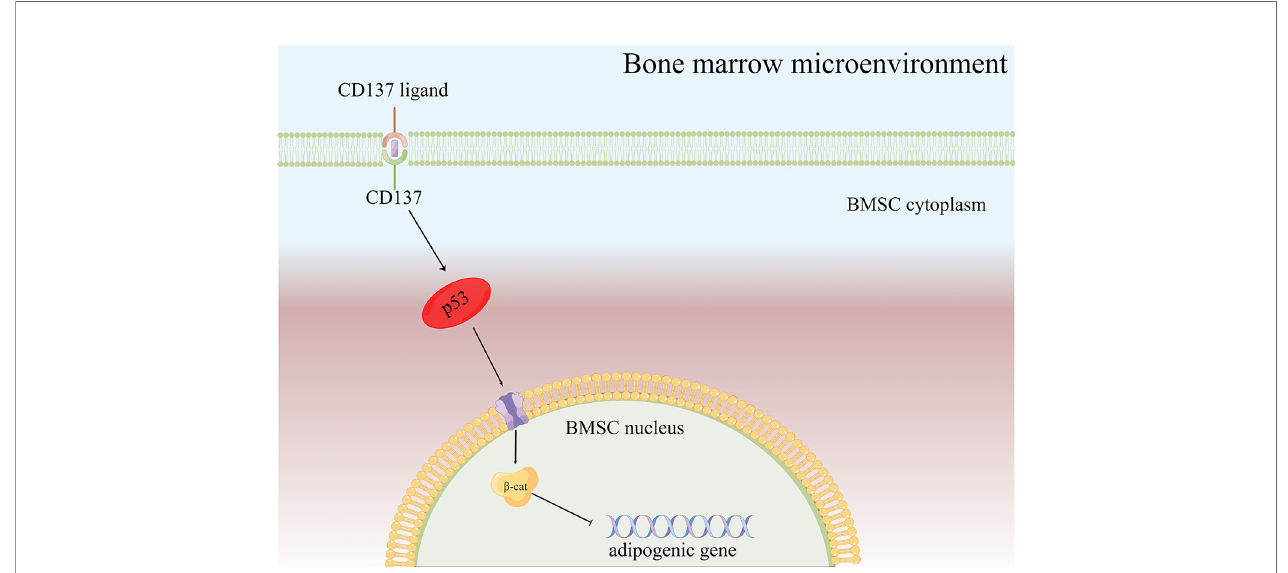
FIGURE 5 | Diagram of the possible mechanism of bone loss via the CD137-p53 Wnt/ b -catenin signaling pathways in aged mice. When CD137L binds to CD137 on BMSCs from aged mice, CD137 signaling is activated so that p53 Wnt/ b -catenin signaling pathway is activated, then promotes the BMSC adipogenic differentiation potential of aged